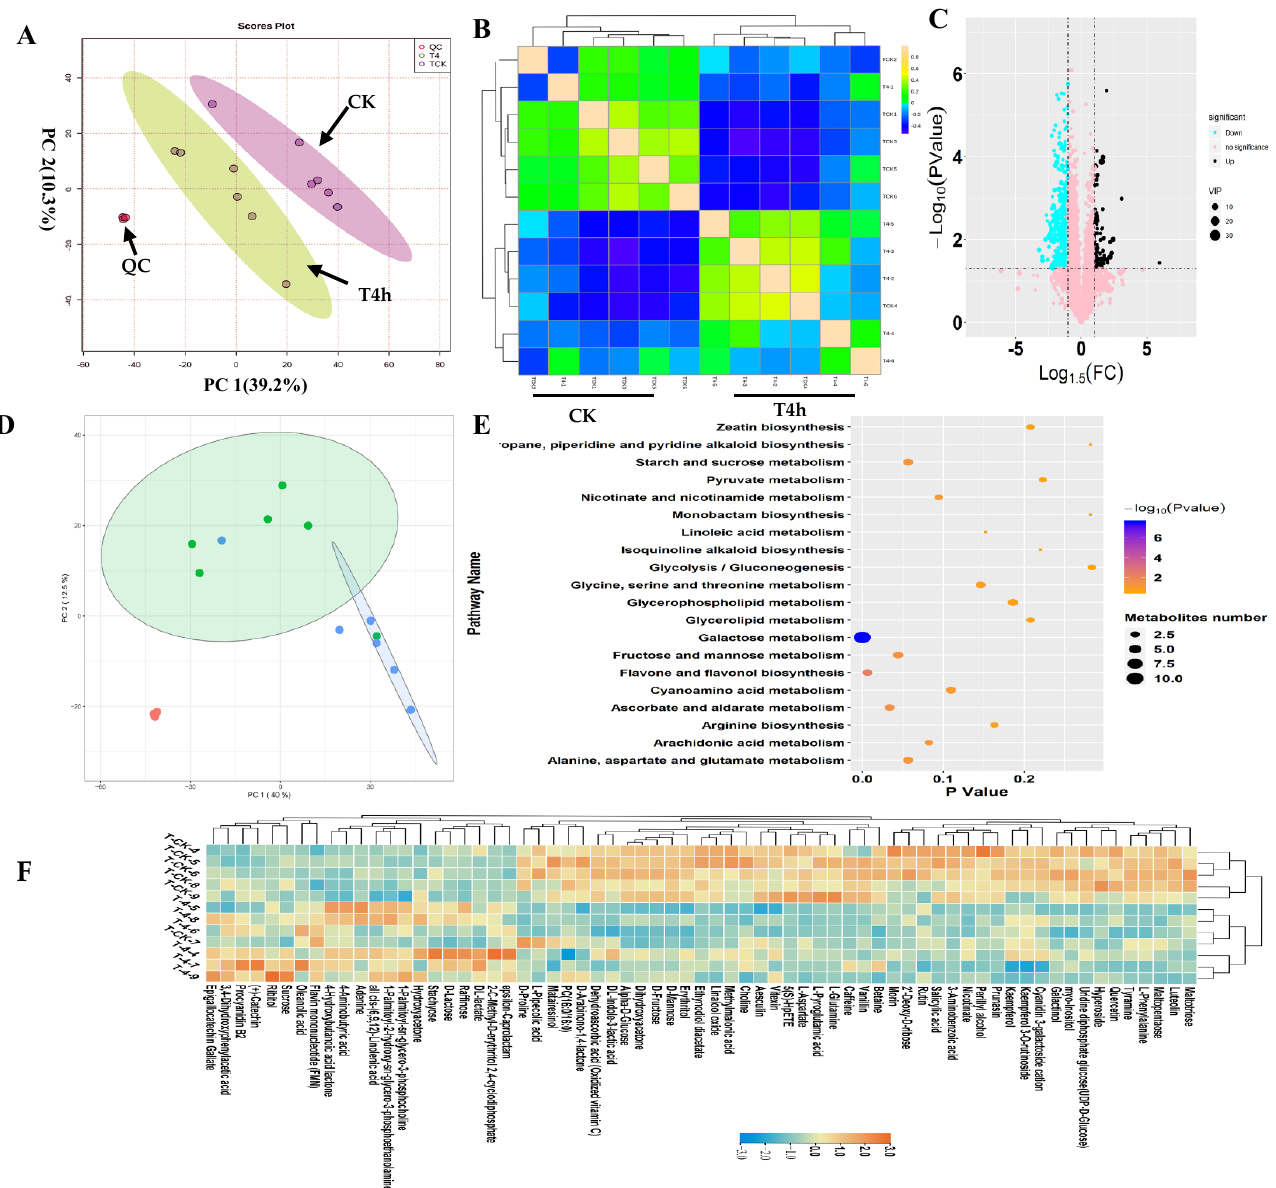
Figure 1. Overview of metabolic patterns of tea following cold stress. ( A ) Results of the PCA analysis on the standardized data matrix. The score plot (left) shows the projection of the samples in the PC1 and PC2 planes. The loading plot shows the distribution of samples from the T4h and control groups, shown in green and blue, respectively. ( B ) Correlation analysis between samples from T4h and control groups. The scale represents the correlation value between two samples. ( C ) Volcano plot showing the differential metabolites in T4h vs. CK (fold changed ≥ 2, p -value ≤ 0.05, VIP > 1.0). The vertical coordinate represents the p -value of the Student’s t -test ( − log 10 p -value). The increased and decreased metabolites are shown in black and blue, respectively. The metabolites labeled pink are not significant. The plot size represents the VIP value of the PLSDA model. ( D ) SOM PCA plot distribution exhibiting two metabolic patterns among all samples. The ellipse represents the 95% confidence interval. ( E ) Scatter plot of the most enriched Kyoto Encyclopedia of Genes and Genomes (KEGG) pathways of differential metabolites. ( F ) Heatmap showing the relative levels of differential metabolites with VIP values > 1.0. The upregulated and downregulated metabolites are shown in red and blue, respectively. The scale represents the normalized peak areas of metabolites.